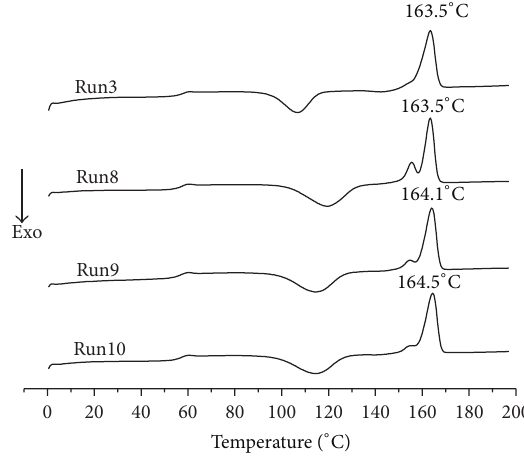
Figure 7: DSC thermogram of the PLA from different molecular weight prepolymers.